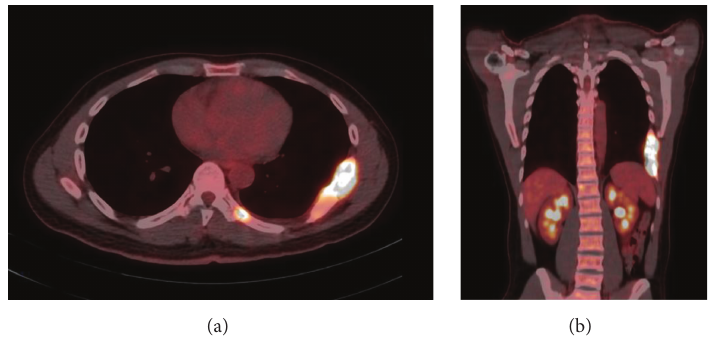
Figure 4: (a) Axial PET-CT demonstrating avid FDG uptake in the destructive lesions involving the 7th, 8th, and 9th ribs. Also a notable focus of FDG uptake is seen left of the T12 vertebra. (b) Coronal PET-CT demonstrating avid FDG uptake in the destructive lesion involving the 7th, 8th, and 9th ribs.